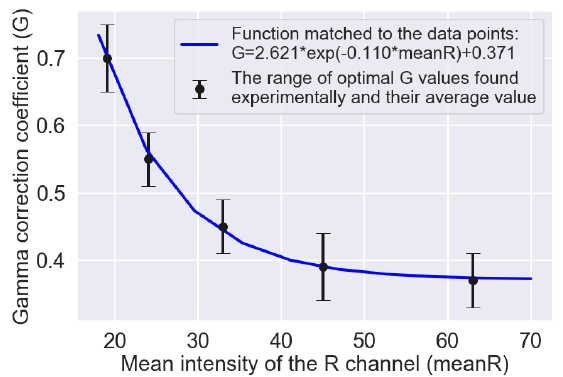
Figure 4. Optimal values of the gamma correction coefficient determined experimentally, based on the segmentation quality, for the mean intensities of the R channel of individual variants (black points). The blue line shows the course of the exponential function matched to the data points.